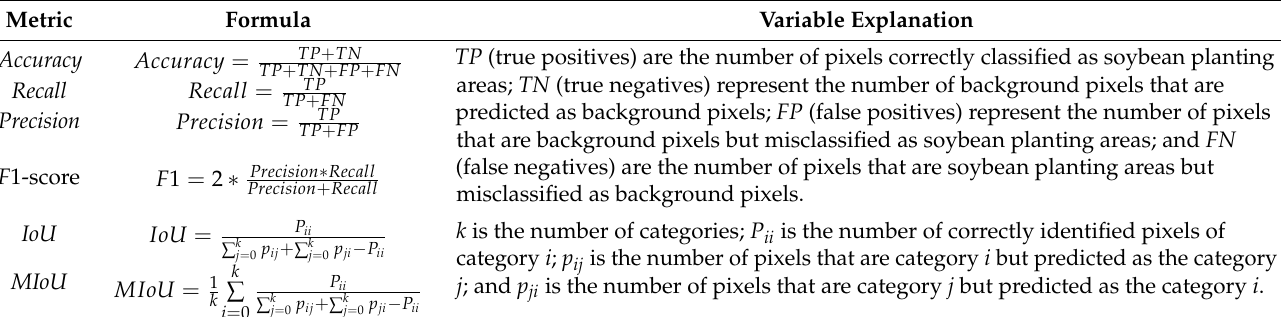
Table 3. Evaluation metrics for assessing